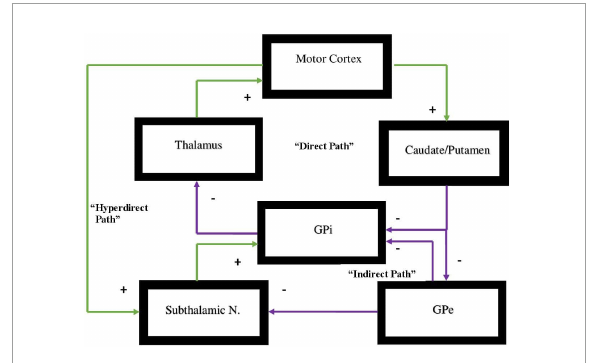
FIGURE1 Representation of the direct vs. indirect pathways of the basal ganglia indicating facilitatory vs. inhibitory components of motor activity. In the direct pathway, Input from the cerebral cortex to the striatum is associated with triggering of inhibitory neurons in the striatum. This subsequently is associated with increased inhibitory output projecting to the globus pallidus-internal [GPi]. Subsequently, decreased inhibitory output from GPi to the ventral anterior [VA] and ventral lateral [VL] nuclei of the thalamus is evidenced that in turn projects through excitatory pathways to the premotor cortex. The direct pathway regulates motor and premotor cortical excitation that is involved in planning and movement initiation. The indirect pathway, when appropriately functioning, should inhibit movement when cortically generated excitatory activity enables inhibitory neurons in globus pallidus external [GPe]. These subsequently inhibit tonic inhibitory output neurons associated with decreased tonic inhibition of the subthalamic nucleus [STN]. The result is increased excitatory output to GPi. Excitatory input to GPi adds inhibitory output from GPi to the thalamus which, in turn, decreases excitatory feedback to cerebral cortex. The result, under normal circumstances, should lead to the inhibition of motor activity. Dopamine supports the activity of the direct pathway suppressing activity of indirect pathway. The hyperdirect pathway is exceptional as it circumvents the striatum with a direct link from the cortex to the subthalamic nucleus, then directing excitatory projections to the GPi. The hyperdirect pathway is key for containing non-purposeful movement. When the system is impaired, individuals are less able to inhibit unplanned motor